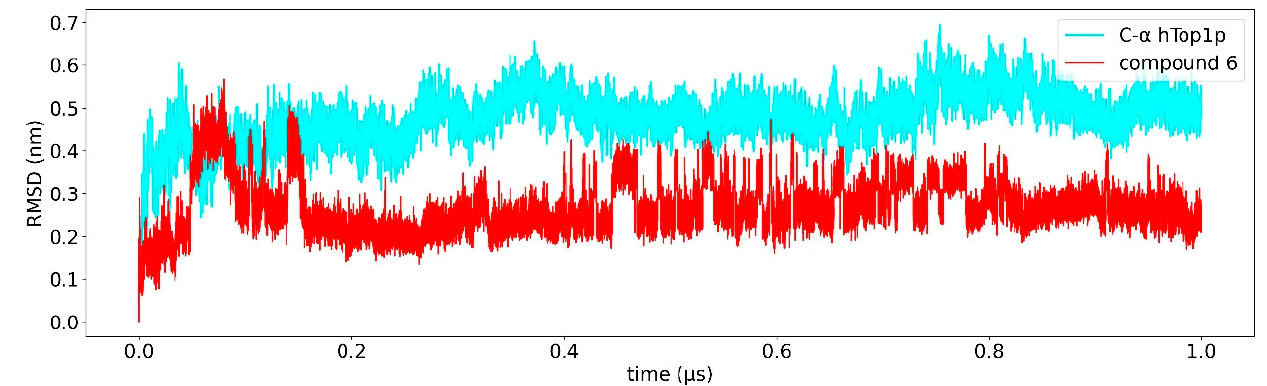
Figure 3. Root mean square deviation (RMSD) relative to 1 us of simulation. The RMSD of C α of the protein is shown in cyan, the RMSD of compound c6 is shown red.